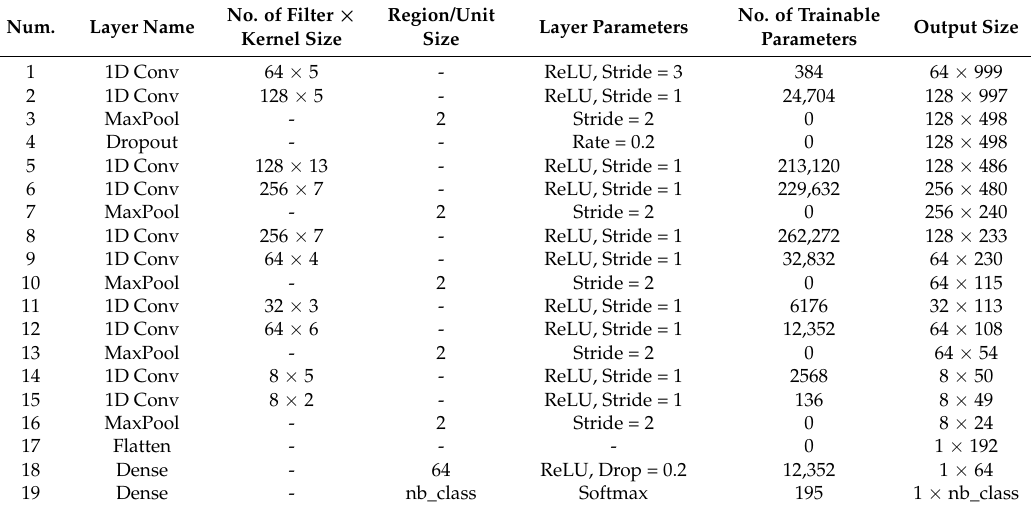
Table 2. Details of layers and parameters used in the proposed 1D-CNN model. model for the classification of sleep stages.